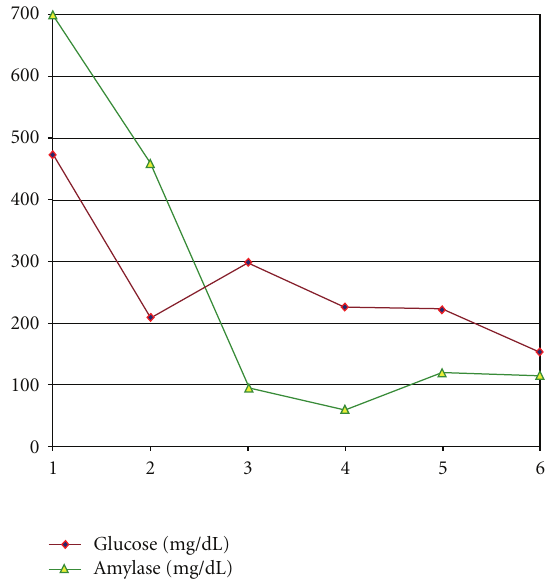
Figure 2: Daily evolution of glucose and amylase levels during the first six hospitalization days.